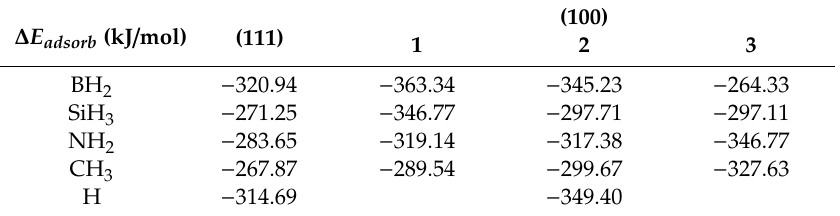
Table 2. CH 3 adsorption energies in the presence of di ff erent adsorbed dopants radicals.